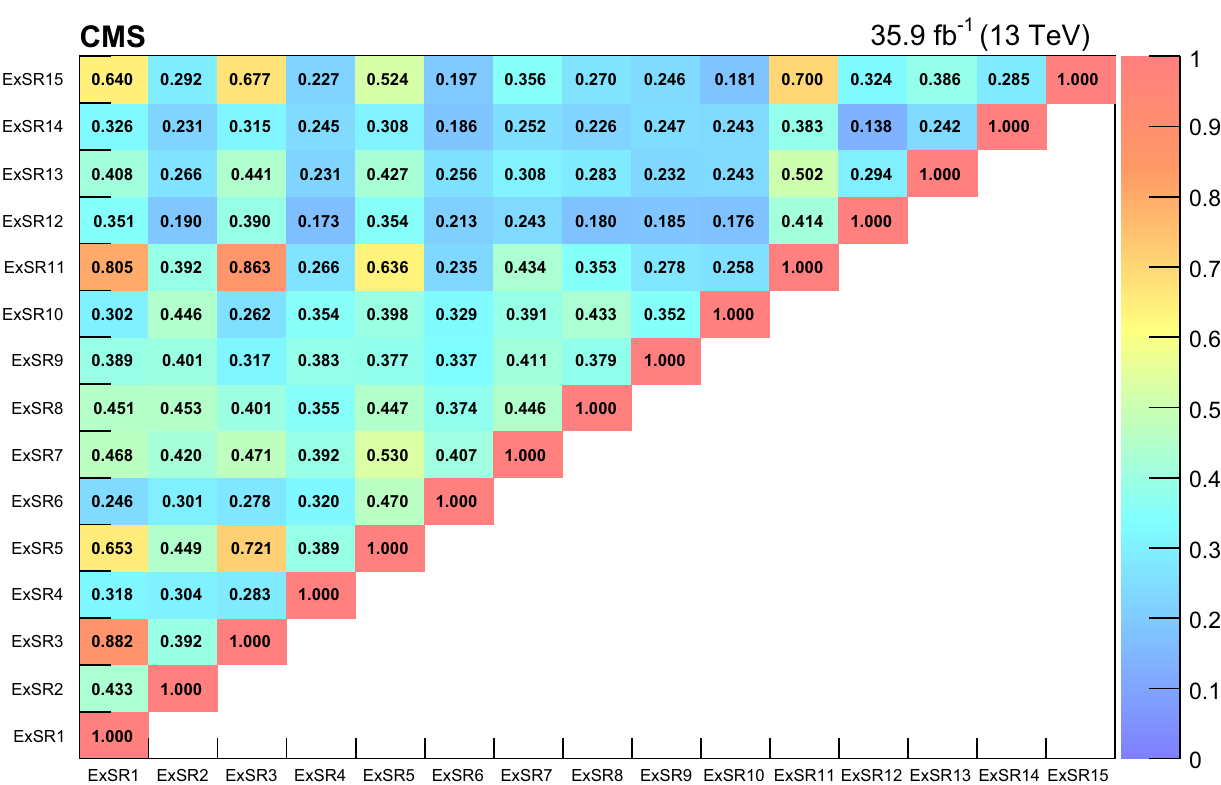
Fig. 10 Correlations between the background predictions in the 15 exclusive